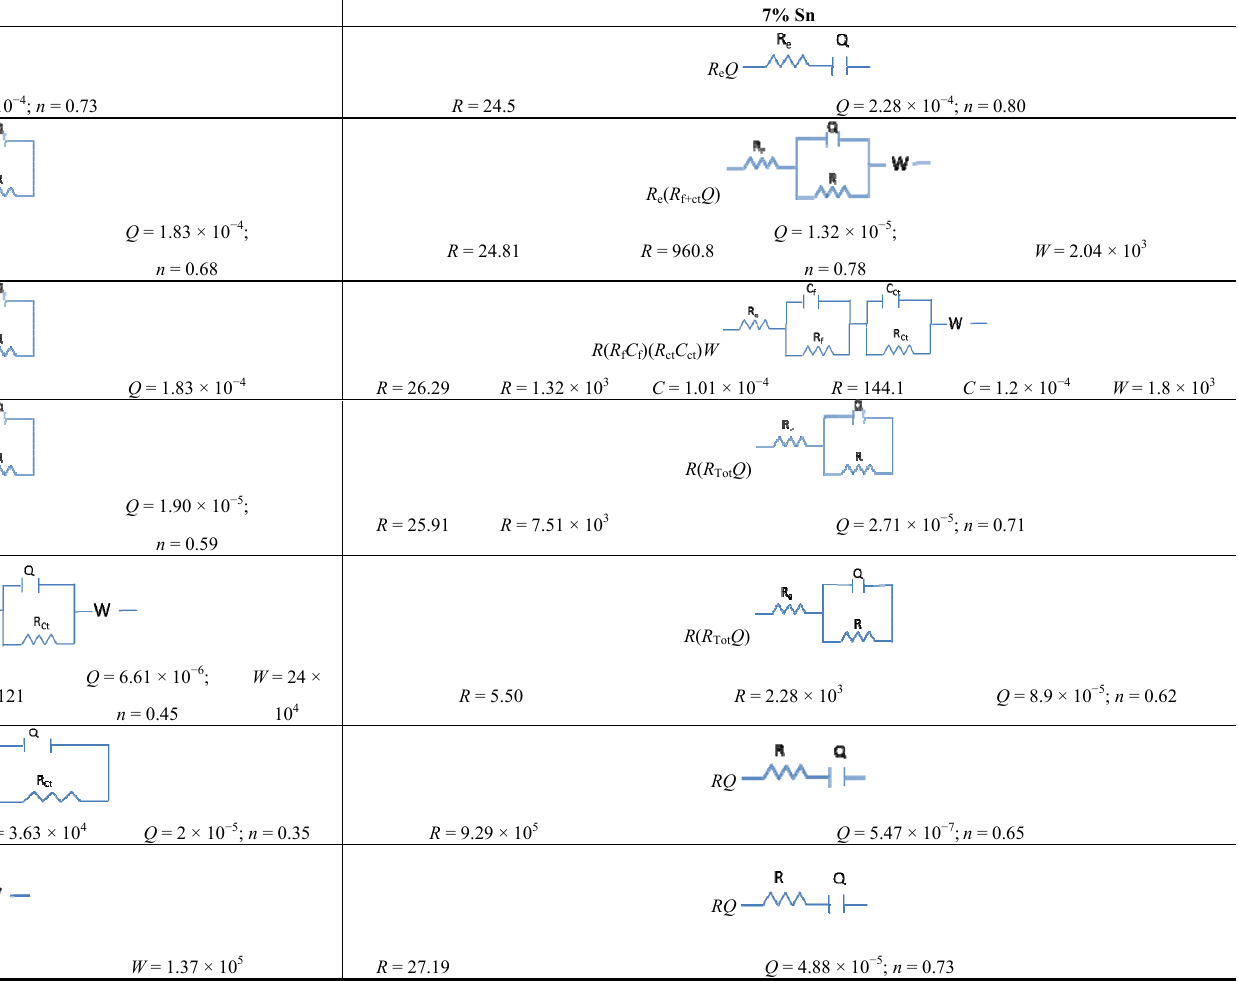
Table 3. Equivalent circuits for 3% Sn bronze and 7% Sn bronze immersed in 0.1 M nitric acid solution. The film resistance ( R capacitance ( C ); the resistance ( R ) and capacitance ( C ) of charge transfer; the resistance of the electrolyte ( R f ct ct phase element ( Q ) and its index n (present only with Q